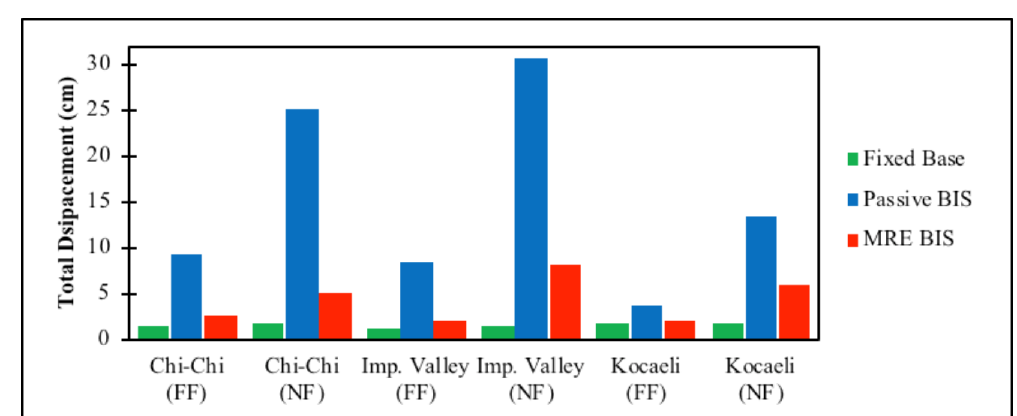
Figure 9. Peak displacement response at top storey against earthquake cases.